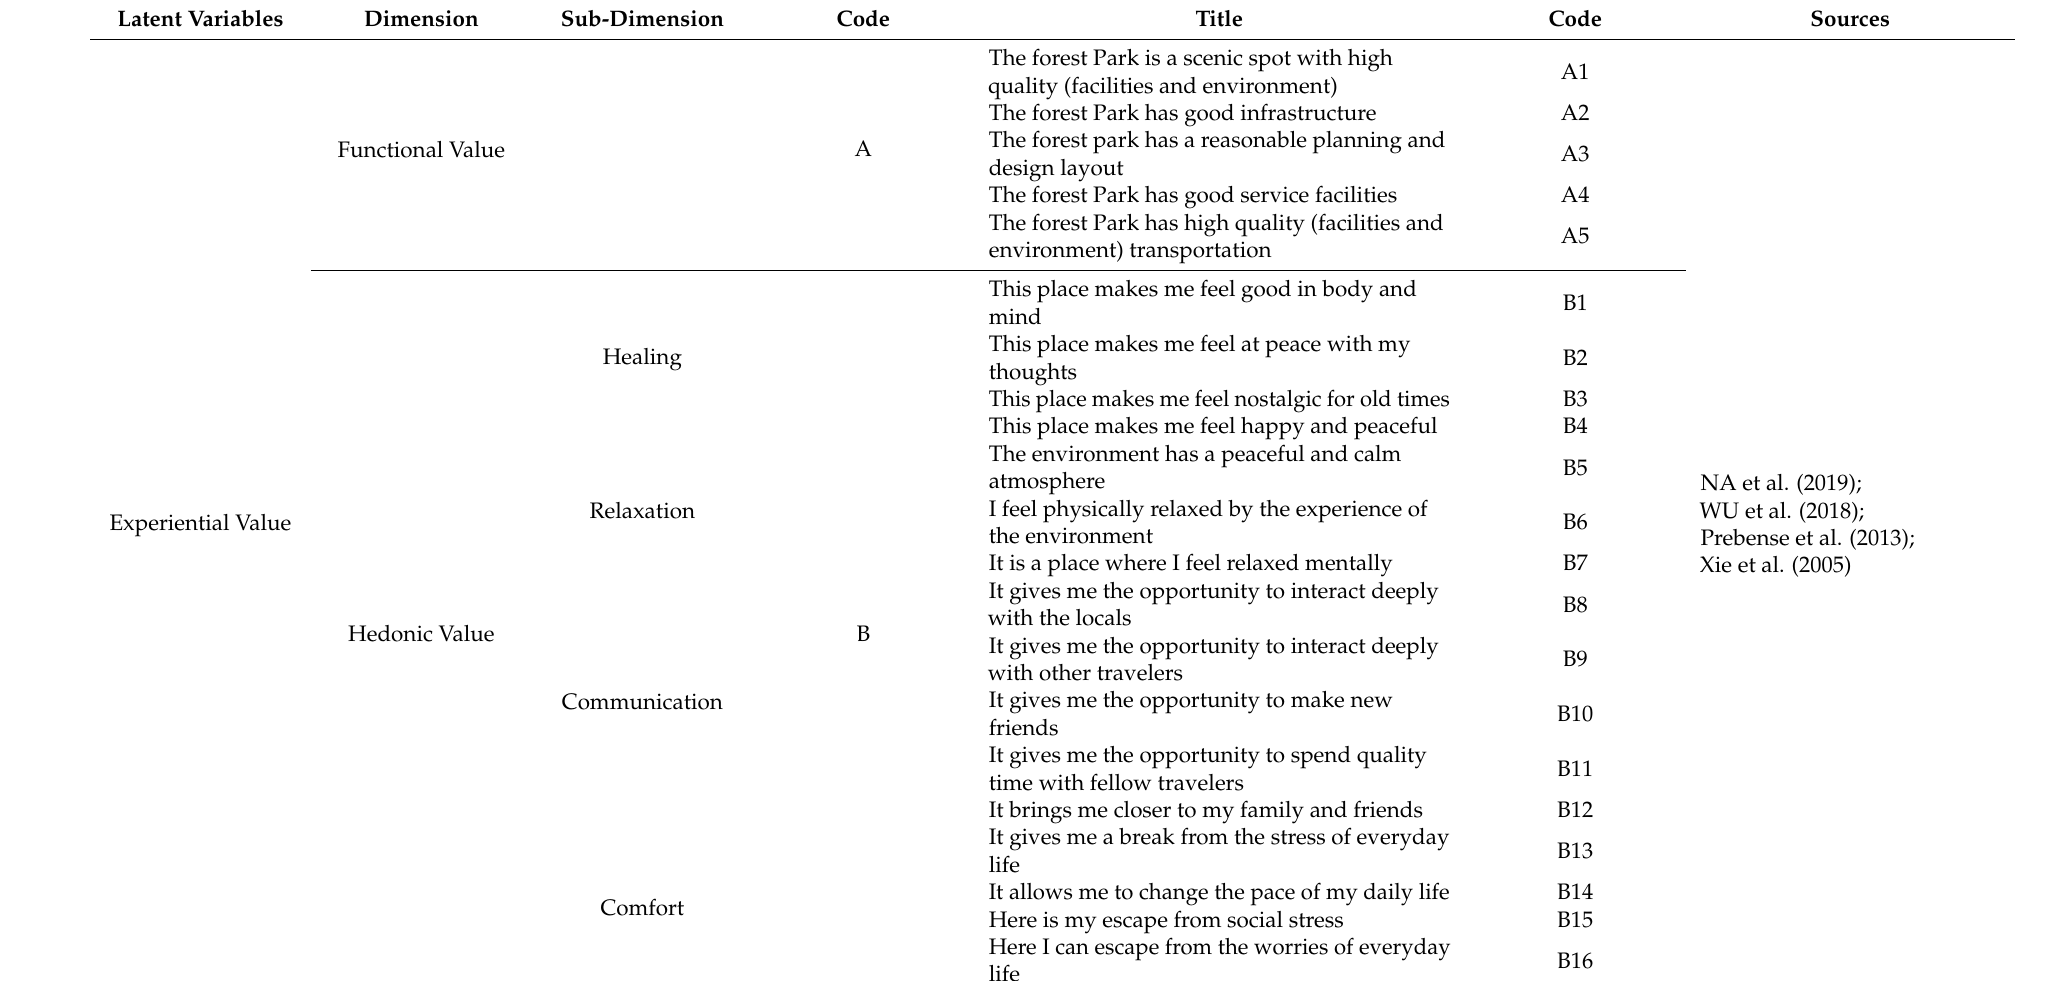
Table 1. Questionnaire scale